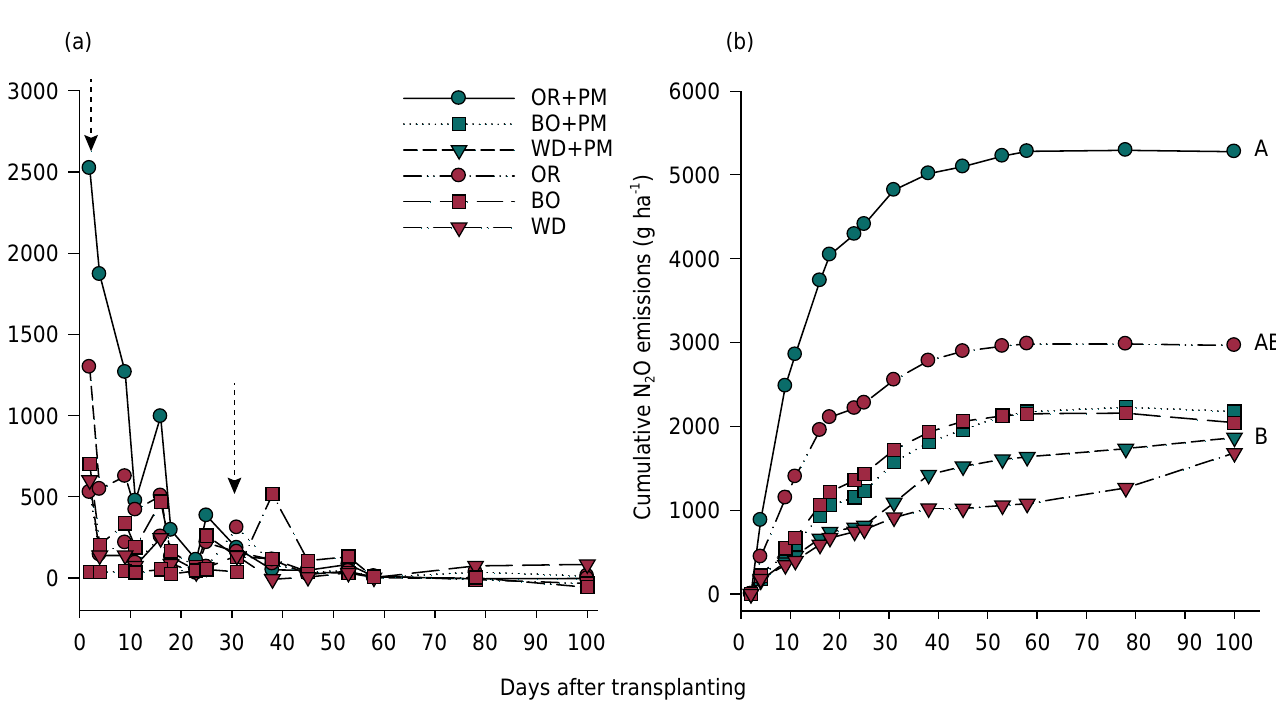
Figure 2. Fluxes (a) and cumulative emission (b) of N 2 O - -N in soil with residues from weeds (WD), weeds + poultry manure (WD + PM), oilseed radishes (OR), oilseed radishes + poultry manure (OR + PM), black oats (BO), and black oats + poultry manure (BO + PM). Dashed arrows indicate fertilization with PM. Means followed by the same letter are not statistically different from each other by the Tukey test at 5 % (n =